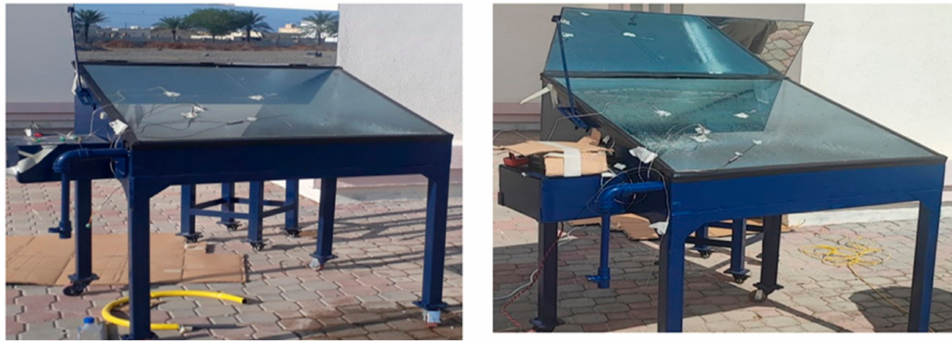
Figure 1. Typical pictures of used solar